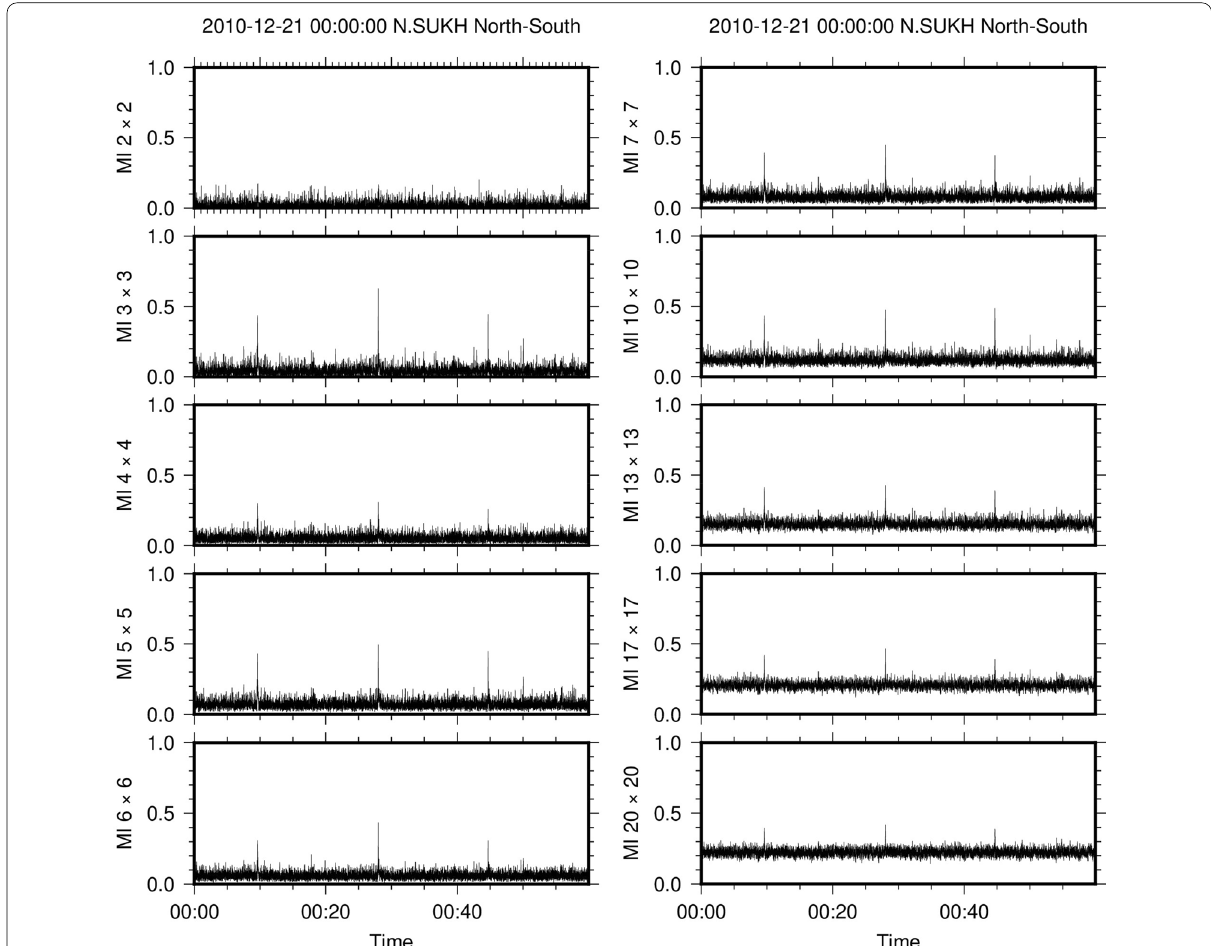
Fig. 14 Time series of MI using 10 different divisions. The time window is one hour from 00:00:00, 21 December 2010 (JST). The template earthquake and observation station (N.SUKH) are as in Fig.